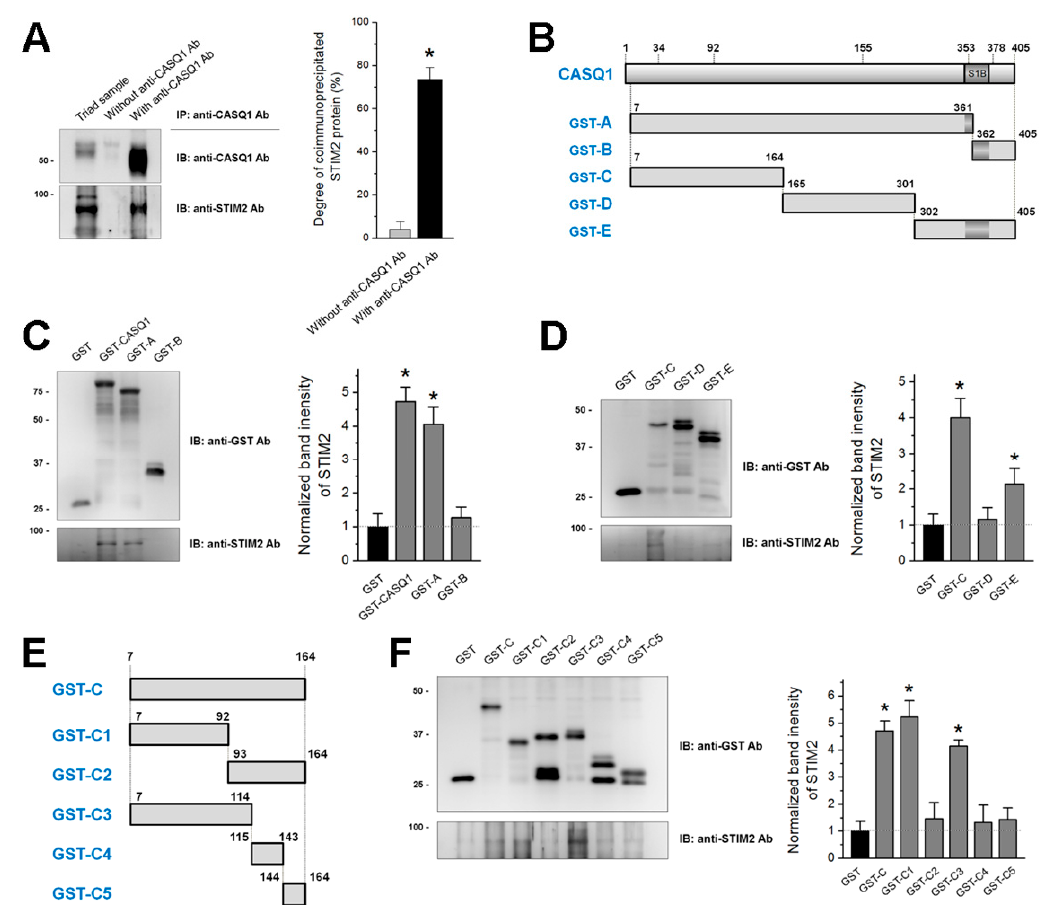
Figure 1. Coimmunoprecipitation of CASQ1 with STIM2 and the binding assay of CASQ1 regions to STIM2: ( A ) Triad samples obtained from rabbit skeletal muscle were subjected to a coimmunoprecipitation assay with anti-CASQ1 antibody. ‘Triad sample’ indicates a simple immunoblot of the triad sample. ‘Without anti-CASQ1 Ab’ indicates a reaction without an anti-CASQ1 antibody. Three independent experiments were conducted, and a representative result is presented. The degree of coimmunoprecipitated STIM2 to total STIM2 is presented as histograms. STIM2 was successfully coimmunoprecipitated with CASQ1. IB, IP, or Ab indicates immunoblot, immunoprecipitation, or antibody, respectively. * Significant difference was compared with ‘without anti-CASQ1 Ab’ ( p < 0.05). ( B , E ) Schematic diagrams of mouse CASQ1 regions are presented. Numbers indicate the sequence of amino acids. The S1B region is presented according to a previous report [35]. ( C , D , F ) The bound proteins that were obtained from the binding assays of GST-CASQ1 or GST-CASQ1 regions with triad samples were subjected to immunoblot assays with anti-GST (to detect GST-CASQ1 or GST-CASQ1 regions) or anti-STIM2 antibody. GST was used as a negative control. Three independent experiments were conducted. The relative amount of STIM2 to the corresponding amount of the CASQ1 region is presented as histograms on the right-hand side. The value for the relative amount of STIM2 to GST was regarded as 1, and others were normalized by this value. * Significant difference compared with GST ( p < 0.05).